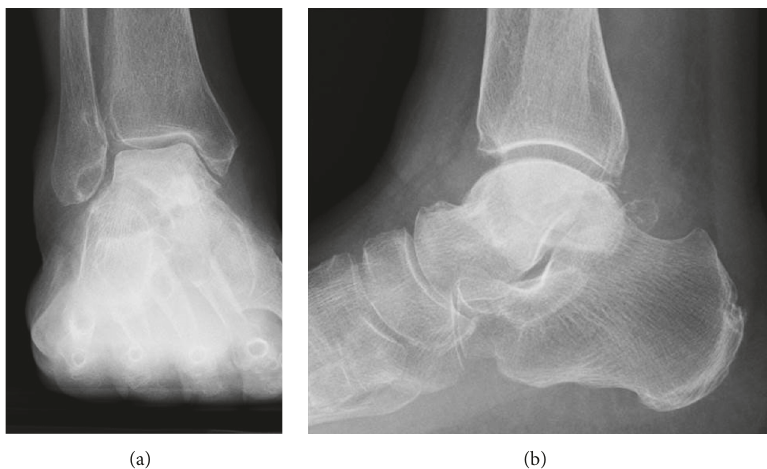
Figure 1: Preoperative radiographs showing sclerotic change of the talar body in anteroposterior (a) and lateral (b) views.